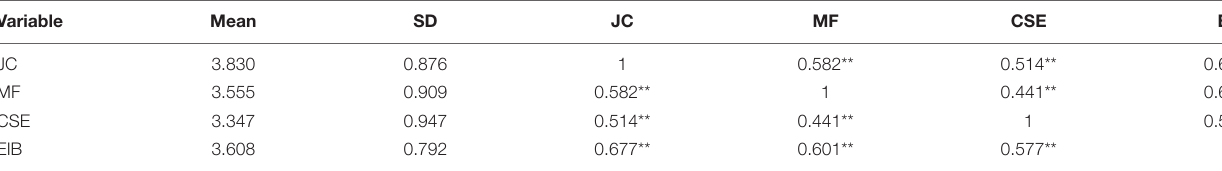
TABLE 3 | Descriptive analysis and correlations among main